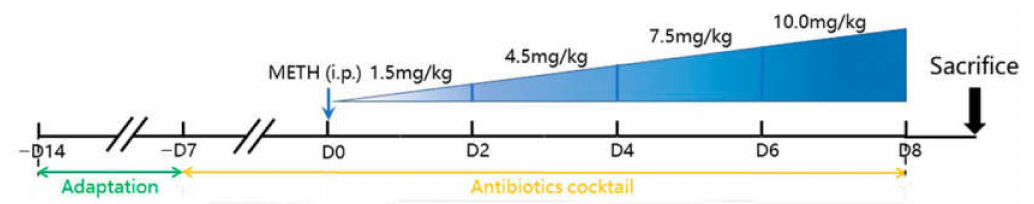
Figure 7. Experimental